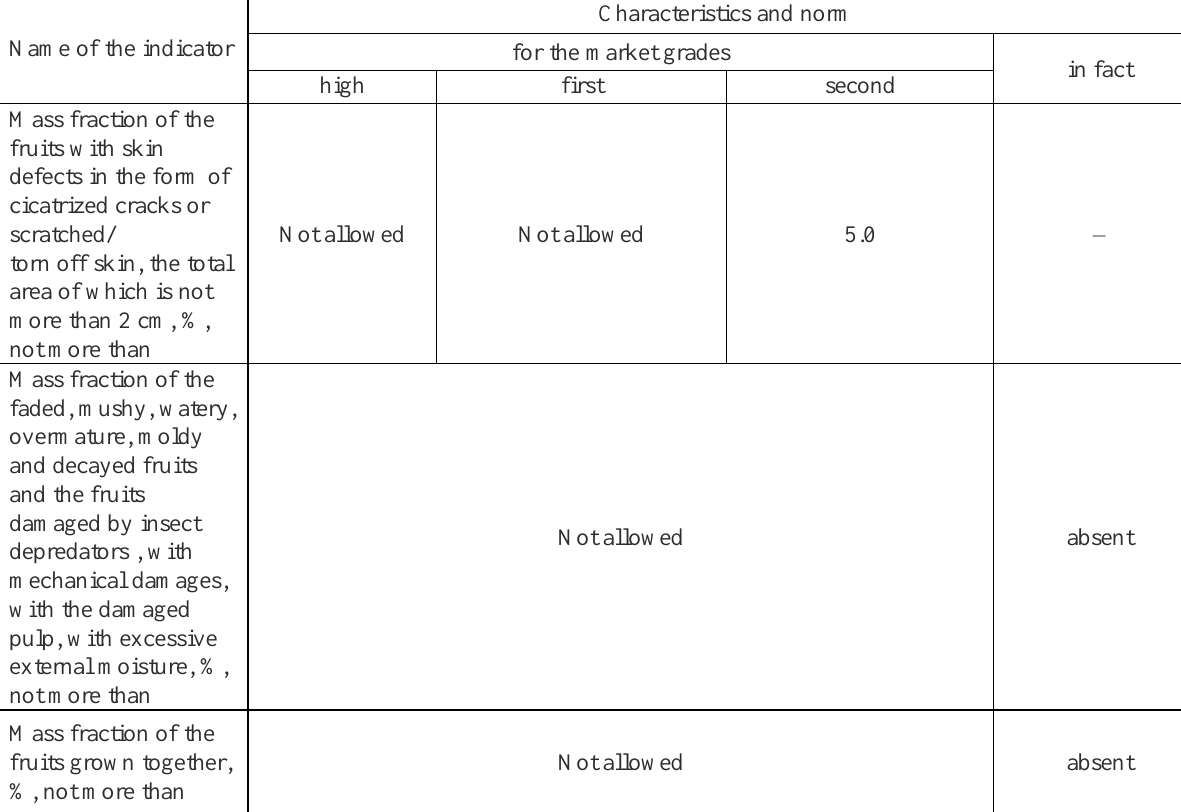
Table 11. Ending. Indicators of quality of fruits of Actinidia deliciosa (kiwi delicious), n = 5 Name of the indicator